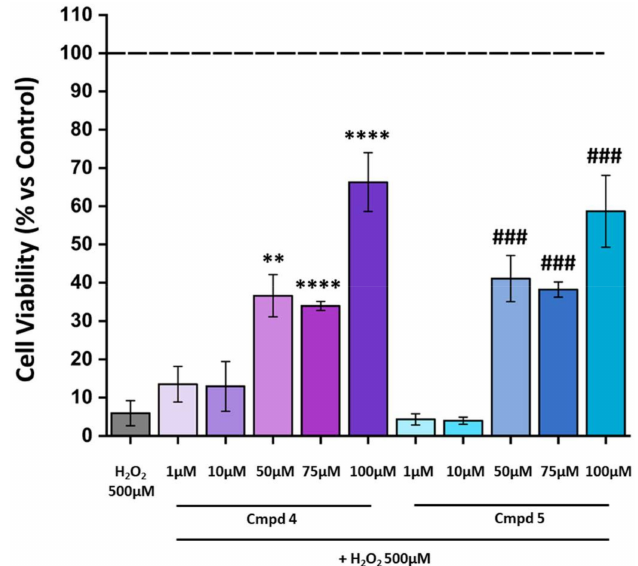
Figure 4. Treatment with 4 or 5 at 100 µ M decreases cell death due to damage with H 2 O 2 . Cell viability was analyzed by CellTiter 96 AQueous One Solution Reagent. The cells were pre-treated for 24 h with compounds 4 or 5 at various concentrations (1–100 µ M) and then exposed for 3 h with H 2 O 2 500 µ M. The dashed line indicates the reference value of the Ctrl (control group: no compounds or H 2 O 2 exposure). The values in the graph indicate % viability as the mean ± SE obtained from n = 3 of independent experiments. Statistics: one-way ANOVA test followed by Levene’s post-test; ** p ≤ 0.01 ( 4 : 50 µ M vs. H 2 O 2 500 µ M); **** p ≤ 0.0001 ( 4 : 75 µ M vs. H 2 O 2 500 µ M; 4 : 100 µ M vs. H 2 O 2 500 µ